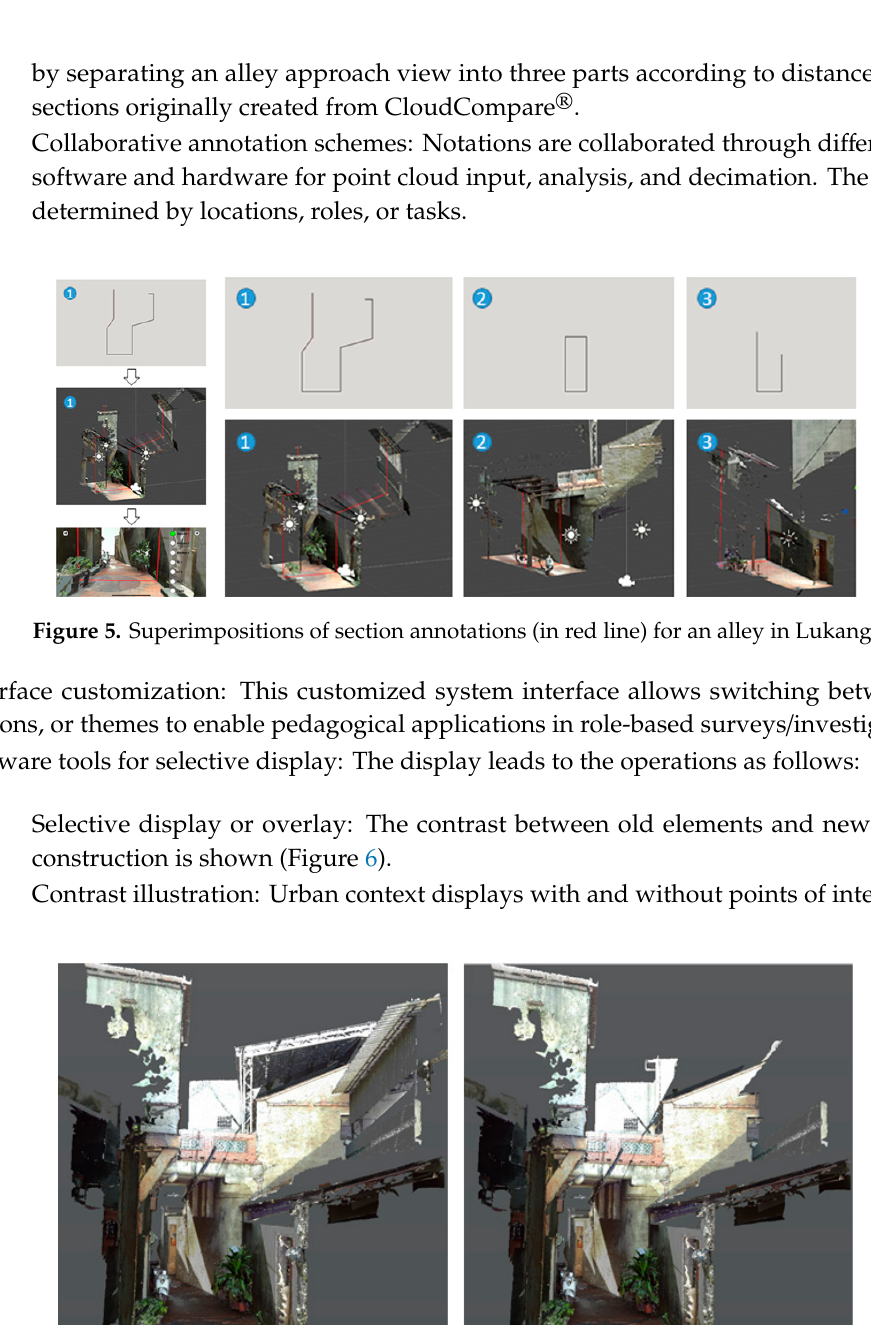
Figure 6. Views of Shih Yih Hall with and without conflict construction removed.